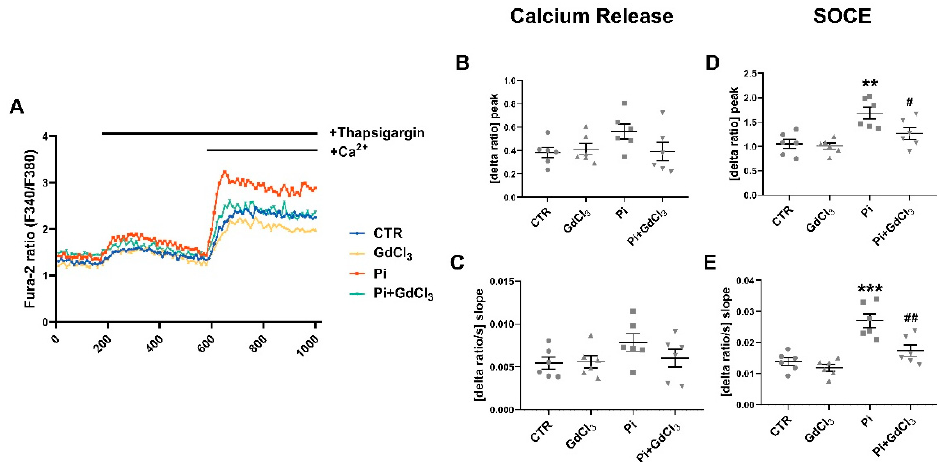
Figure 6. Reversal of ß-glycerophosphate-induced increase in store-operated Ca 2+ entry (SOCE) in megakaryocytes by GdCl 3 . ( A ) Representative tracings of Fura-2 fluorescence ratio in fluorescence spectrometry before and following extracellular Ca 2+ removal and addition of thapsigargin (1 µ M) as well as re-addition of extracellular Ca 2+ in megakaryocytes without (CTR) or with prior 24-h exposure to 50 µ M GdCl 3 alone (GdCl 3 ), 2 mM ß-glycerophosphate alone (Pi) or 2 mM ß-glycerophosphate and 50 µ M GdCl 3 (Pi+GdCl 3 ). ( B , C ) Arithmetic means ( ± SEM, n = 6) of peak ( B ) and slope ( C ) increase in Fura-2 fluorescence ratio following addition of thapsigargin (1 µ M) in megakaryocytes without (CTR) or with prior 24-h exposure to 50 µ M GdCl 3 alone (GdCl 3 ), 2 mM ß-glycerophosphate alone (Pi) or 2 mM ß-glycerophosphate and 50 µ M GdCl 3 (Pi+GdCl 3 ). ( D , E ) Arithmetic means ( ± SEM, n = 6) of peak ( D ) and slope ( E ) increase in Fura-2 fluorescence ratio following re-addition of extracellular Ca 2+ in megakaryocytes without (CTR) or with prior 24-h exposure to 50 µ M mM GdCl 3 alone (GdCl 3 ), 2 mM ß-glycerophosphate alone (Pi) or 2 mM ß-glycerophosphate and 50 µ M GdCl 3 (Pi+GdCl 3 ). ** ( p < 0.01), *** ( p < 0.001) indicate statistically significant differences compared to CTR; # ( p < 0.05), ## ( p < 0.01) indicate statistically significant differences compared to Pi alone (ANOVA). CTR,